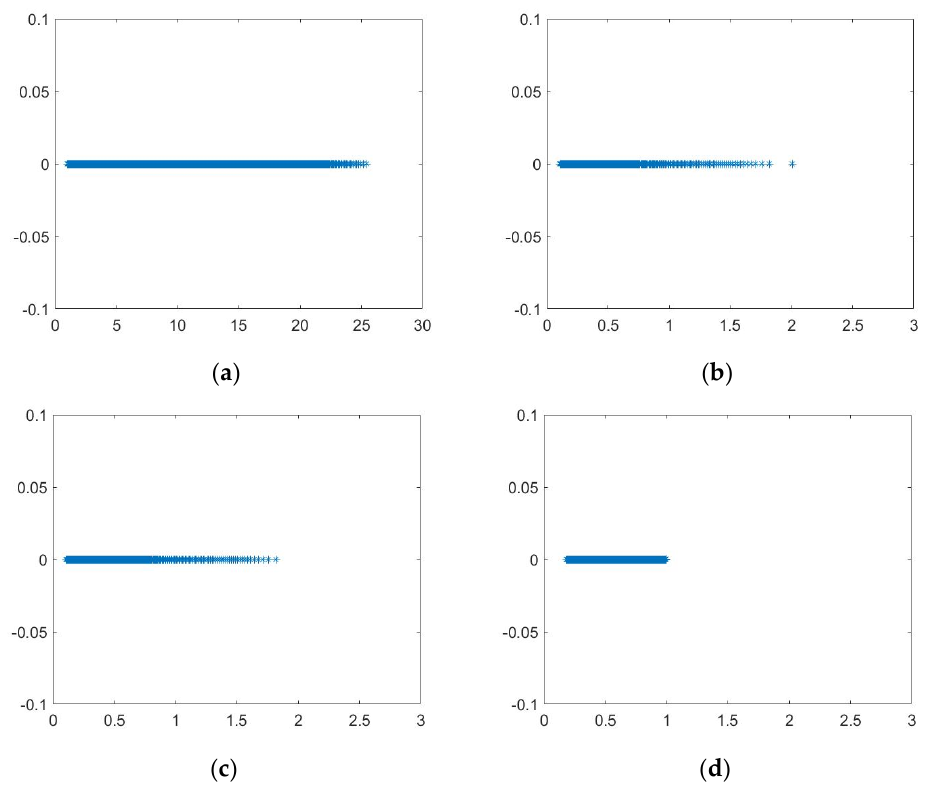
Figure 2. The eigenvalues of the matrix A ( a ), DCS preconditioned matrix ( b ), DTS τ preconditioned matrix ( c ) and FMDTS preconditioned matrix ( d ) of Example 2. Figure 2 plot the distribution of the eigenvalues of the matrix A , DCS precondi- tioned matrix, D T S preconditioned matrix and FMDTS preconditioned matrix of Ex- ample 2 at order 1 . 2 = and 10 2 n = . In Figure 2, we can see that the spectral radius of the FMDTS preconditioned matrix has dropped significantly by nearly 20 times, eigen- values of the matrix A are clustered within 30, and the eigenvalues of the FMDTS pre- conditioned matrix are clustered within 1.5. The spectral radius of the FMDTS precondi- tioned matrix is more clustered than that of the DCS preconditioned matrix and D T S